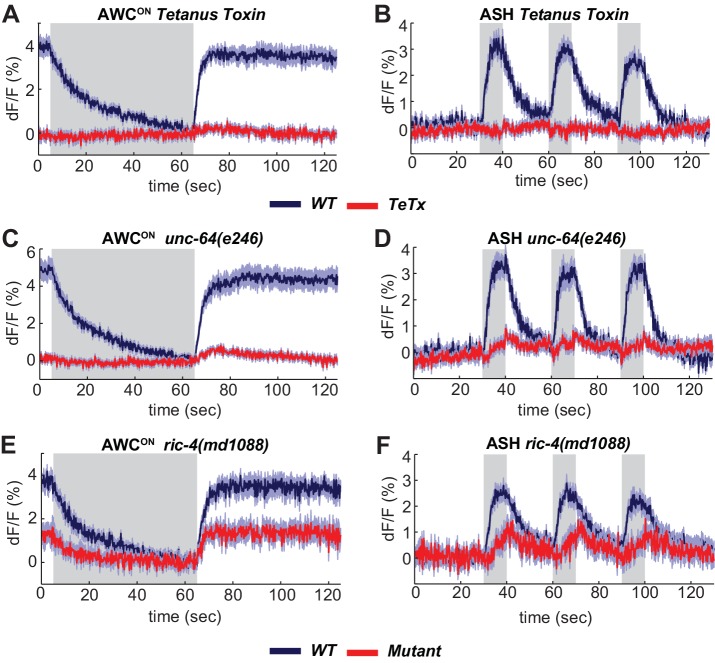
The SNARE complex is required for VGLUT-pH responses in AWCON and ASH.(A,B) VGLUT-pH responses are eliminated by cell-specific expression of TeTx light chain. (A) AWCON
str-2 promoter driving TeTx n = 25 (9 animals, 2–3 trials each). AWCON
wt (TeTx-array negative animals tested in parallel) n = 28 (10 animals, 2–3 trials each). (B) ASH sra-6 promoter driving TeTx n = 33 (11 animals, three trials each). ASH wt (TeTx-array negative animals tested in parallel) n = 24 (8 animals, three trials each). (C,D) VGLUT-pH responses in unc-64(e246) (partial loss of function) syntaxin mutants. (C) AWCON
unc-64(e246) n = 30 (10 animals, three trials each). AWCON
wt n = 23 (9 animals, 2–3 trials each). (D) ASH unc-64(e246) n = 24 (8 animals, three trials each). ASH wt n = 18 (6 animals, three trials each). (E, F) VGLUT-pH responses in ric-4(md1088) (partial loss of function) SNAP-25 mutants. (E) AWCON
ric-4(md1088) n = 12 (4 animals, three trials each). AWCON
wt n = 15 (5 animals, three trials each). (F) ASH ric-4(md1088) n = 16 (6 animals, 2–3 trials each). ASH wt n = 32 (11 animals, 2–3 trials each). Mutations are described in Supplementary file 2. All differences are significant (p<0.0001, unpaired t-test), as detailed in Supplementary file 3A. Gray areas mark stimulus periods. Shading indicates S.E.M.10.7554/eLife.31234.010Figure 3—source data 1.Source data for Figure 3.